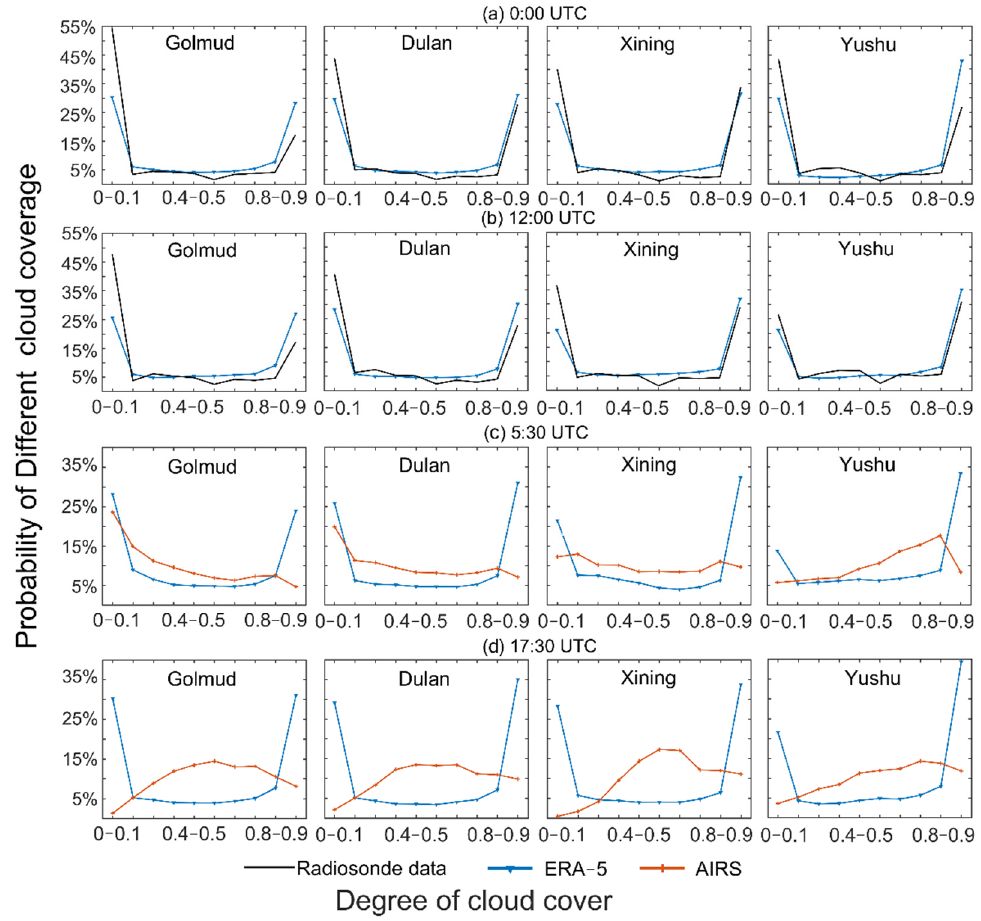
Figure 8. Probability diagram of different cloud cover at different time. ( a ) At 0:00 UTC, in ERA-5 and Meteorological station data, Probability of occurrence of different cloud cover at each station. ( b ) At 12:00 UTC, in ERA-5 and Meteorological station data, Probability of occurrence of different cloud cover at each station. ( c ) At 5:30 UTC, in ERA-5 and AIRS data, Probability of occurrence of different cloud cover at each station. ( d ) At 17:30 UTC, in ERA-5 and AIRS data, Probability of occurrence of different cloud cover at each station.